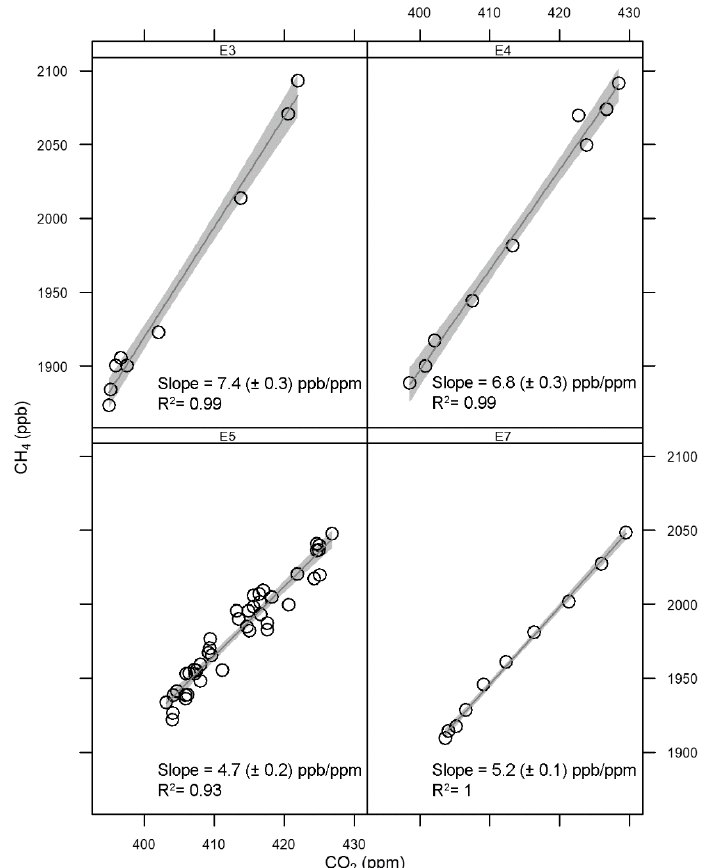
Figure 5. Linear regressions of hourly mean mixing ratios of CH 4 and CO 2 for four pollution events (CH 4 data not available for E1, E2, and E6). The slope and coefficient of determination R 2 are given. The shaded areas around the regressions line represent the range in which the true regression line lies at a certain level of confidence (95% in the plot). The slope of the regressions corresponds to CH 4 /CO 2 emission ratios.